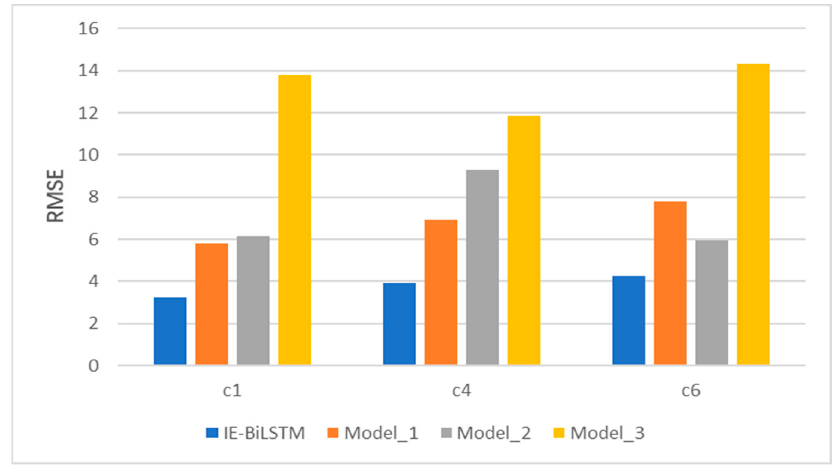
Figure 12. Estimation performance of different models using the PHM2010 testing dataset.